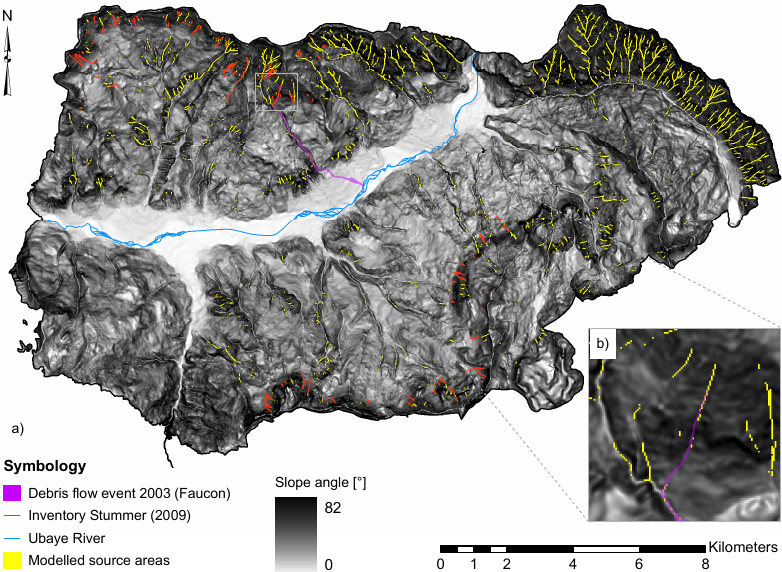
Fig. 4. Potential source areas identified by the model in comparison with the inventory by Stummer (2009) and the 2003 event observed in the Faucon catchment (Remaˆıtre, 2006) (a) and an amplification of the upslope region of the Faucon catchment where the 2003 event had been triggered (b) .